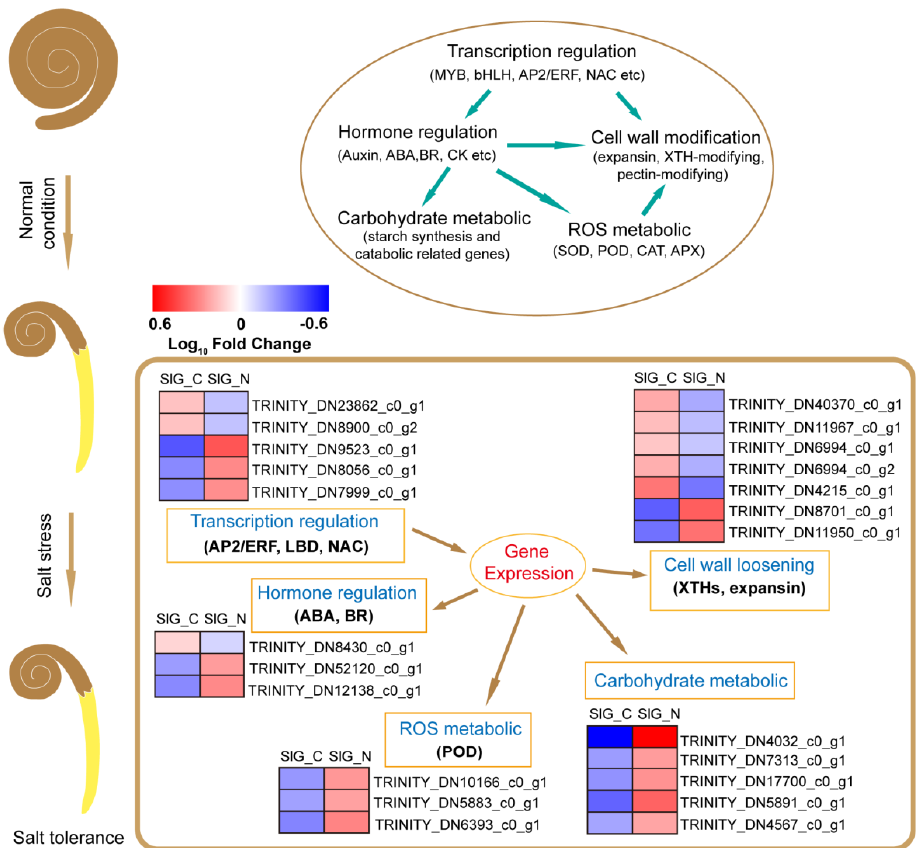
Figure 9. Schematic representation of the molecular response and mechanisms underlying tolerance to salt stress during brown seed germination in S. liaotungensis .